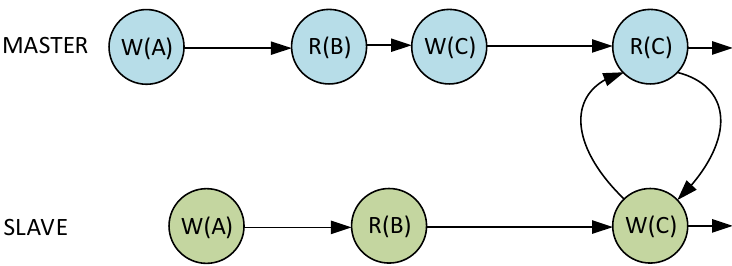
Figure 7. Potential source of deadlock between master and slave cores.